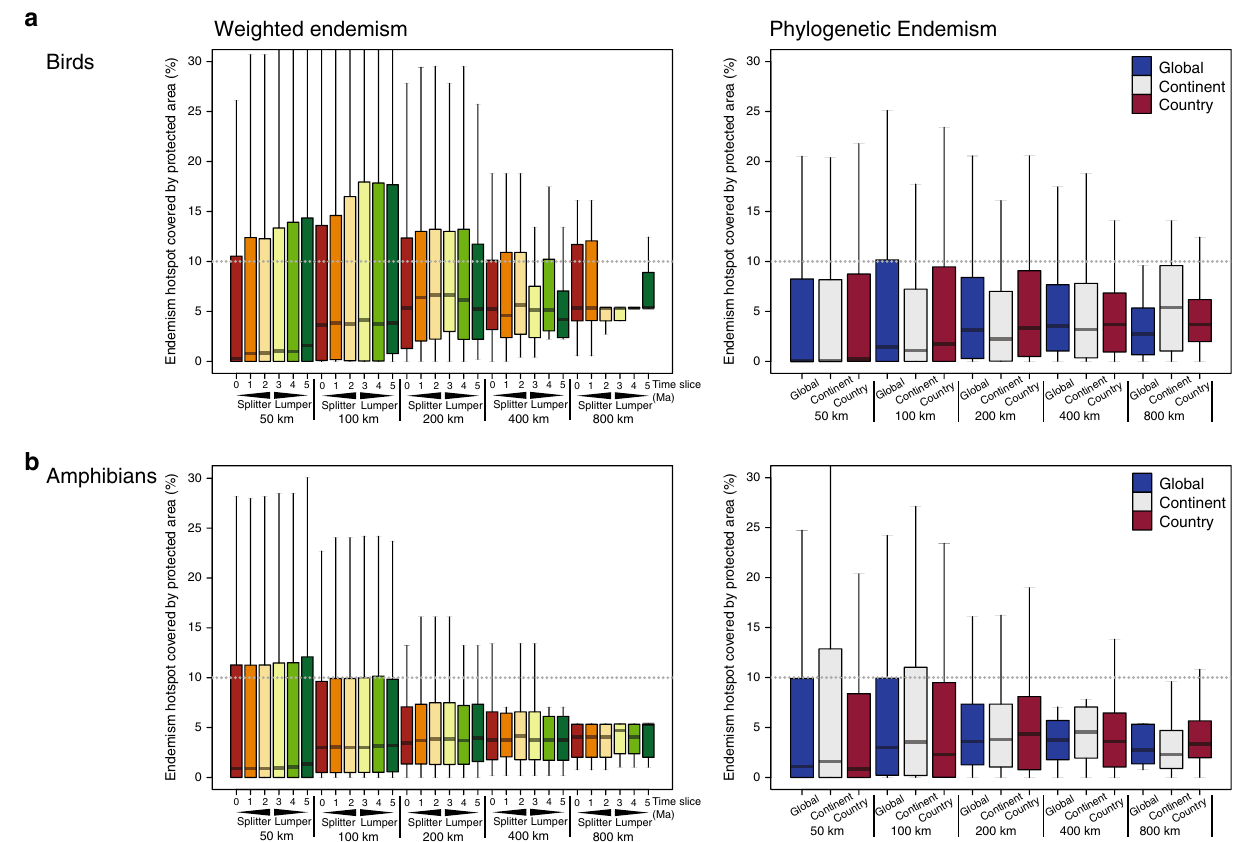
Fig. 5 Relationship between variation in grain size and the proportion of endemism hotspots covered by the global systems of protected areas. a Bird ( n = 10,018 species) weighted endemism (left) and phylogenetic endemism (right), and b amphibian ( n = 5872 species) weighted endemism (left) and phylogenetic endemism (right). Weighted endemism was calculated by weighting species according to their range sizes, whereas phylogenetic endemism weights phylogenetic branches by the inverse of geographical range size of that branch, such that the branch lengths of range-restricted species are given more weight. The dotted lines represent the 10% threshold corresponding to the minimum representation target for sustaining species persistence. These fi ndings demonstrate widespread de fi cits of protection for endemism hotspots regardless of grain size, spatial extent or taxonomic treatment. The bottom and top of boxes show the fi rst and third quartiles respectively, the median is indicated by the horizontal line, the range of the data by the whiskers. Source data are provided as a Source Data fi